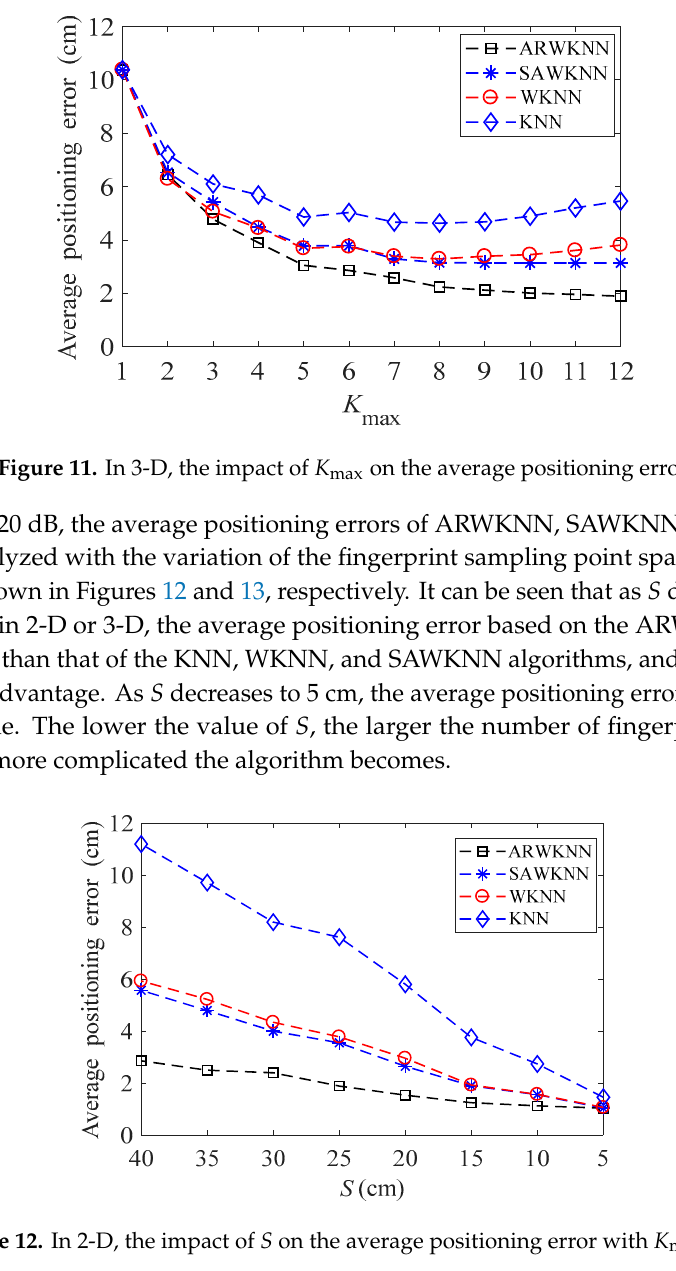
Figure 10. In 2-D, the impact of K max on the average positioning error.